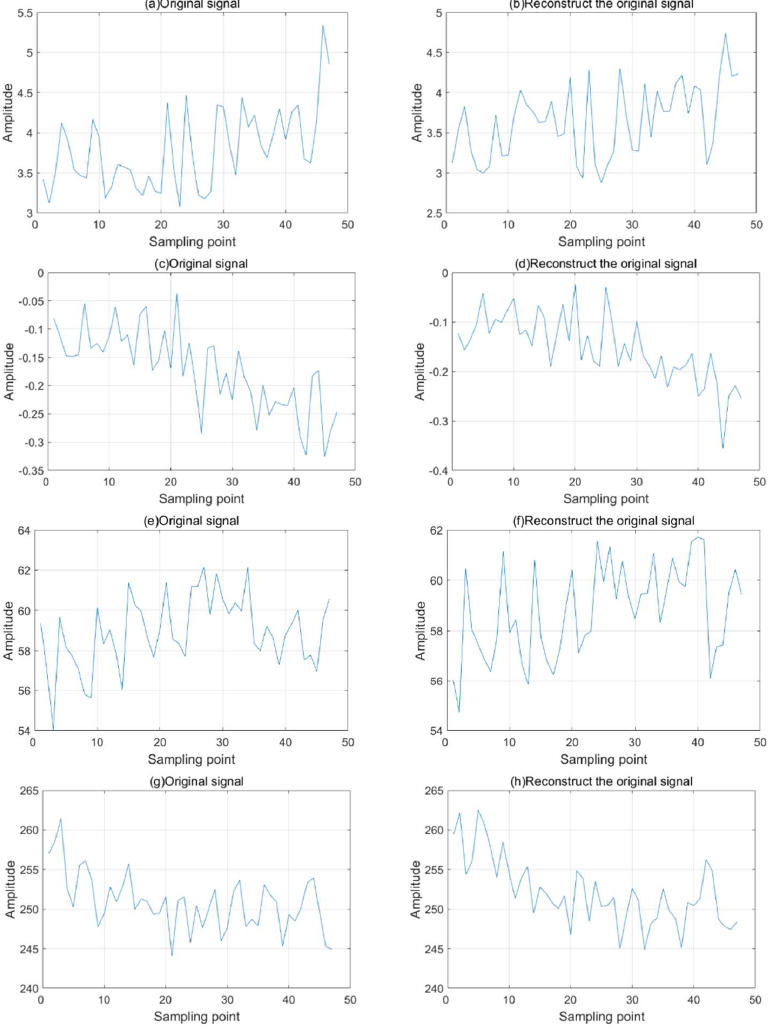
Figure 8. Original and reconstructed time series. ( a , b ) precipitation; ( c , d ) sea surface heat flux; ( e , f ) total cloud cover; ( g , h ) long-wave radiation .